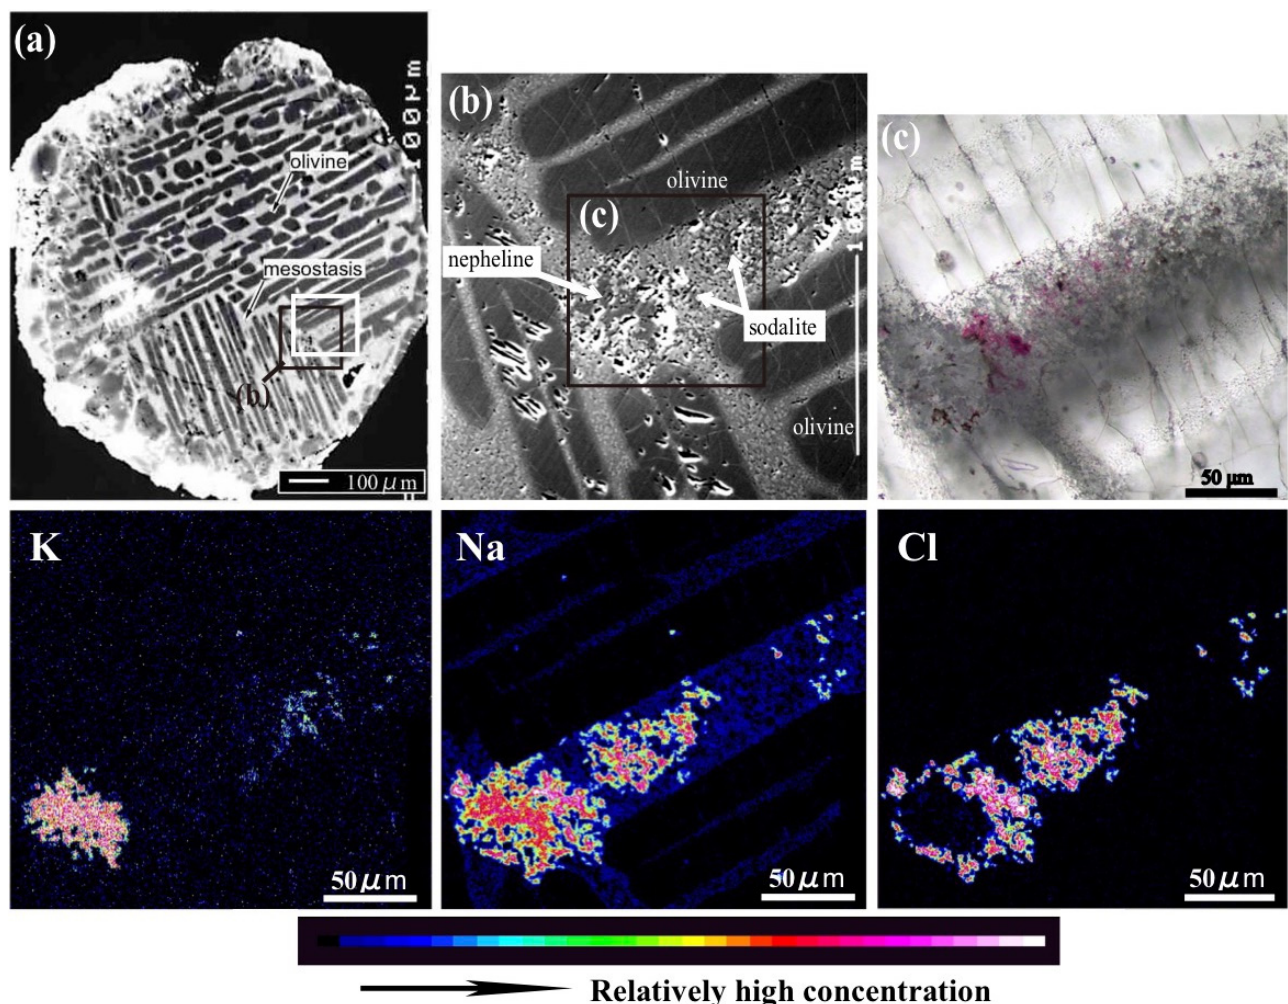
Figure 3. ( a ) BSE image of barred olivine chondrule (BOC-01). ( b ) Enlarged BSE image of the black boxed area in ( a ), showing the occurrence of nepheline and sodalite in mesostasis. White line is a scale of 100 microns. ( c ) Optical photomicrograph (plane-polarized view) of a boxed area of ( b ), showing pinkish sodalite. K–Na–Cl X-ray maps of the white boxed area in ( a ) are also shown. POC-06 contains mainly olivine, low-Ca pyroxene, and Al-rich clinopyroxene, with secondary nepheline and minor amounts of sodalite. Olivine is mainly forsterite (X Mg = 0.91–0.99 (see Supplementary Table S1)). Olivine of the rim part of the chondrule (Figure 2) gives 0.64 of X Mg . Low-Ca pyroxene contains 1.1 wt% Al 2 O 3 , 0.5 wt% CaO, and 0.5 wt% Cr 2 O 3 with X Mg = 0.99. Al-rich clinopyroxene contains 5.5–14.8 wt% Al 2 O 3 , 0.5–1.6 wt% TiO 2 , 1.02–1.36 wt% Cr 2 O 3 , and 0.03–1.29 wt% Na 2 O; X Mg ranges from 0.96 to 0.99. Nepheline contains 1.6–2.0 wt% K 2 O.